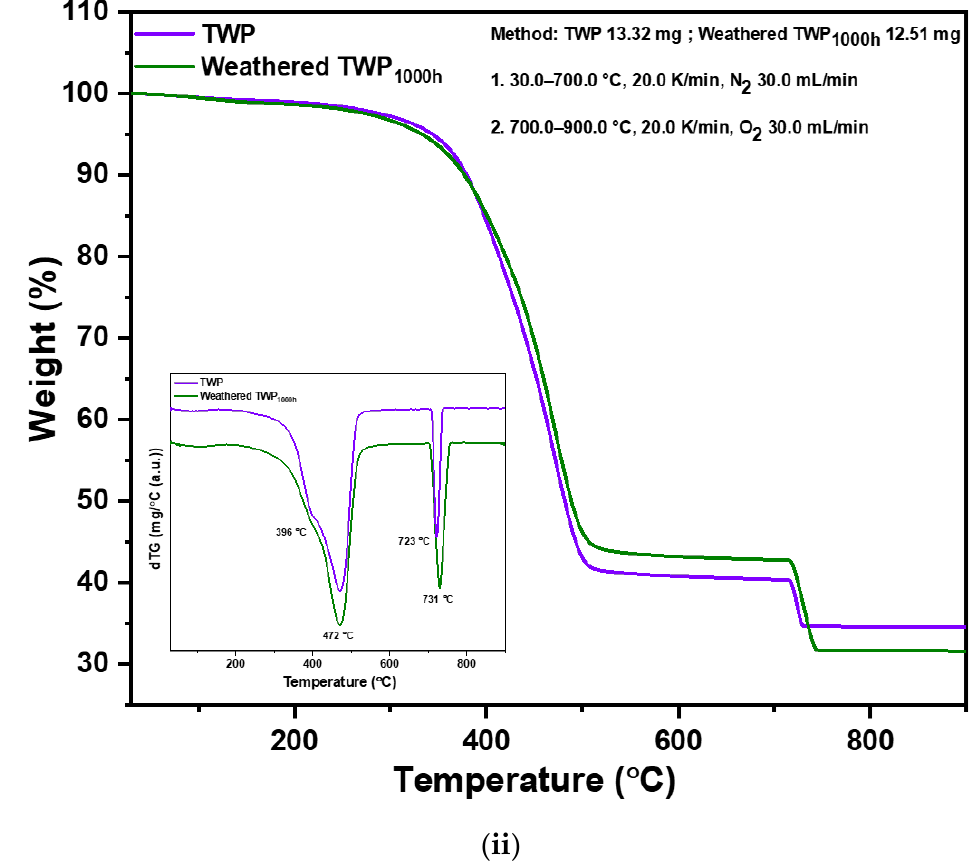
Figure 2. TGA of ( i ) PE, weathered PE 1000h ( ii ) TWP, weathered TWP 1000h . First differentials are shown in the inset. Table 1. Thermal profile determined for (i) PE (ii) weathered PE 1000h (iii) TWP (iv) weathered TWP 1000h .